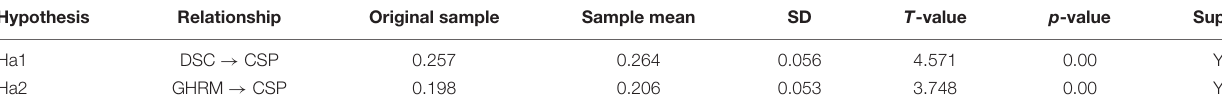
TABLE 9 | Path analyses for the main model.